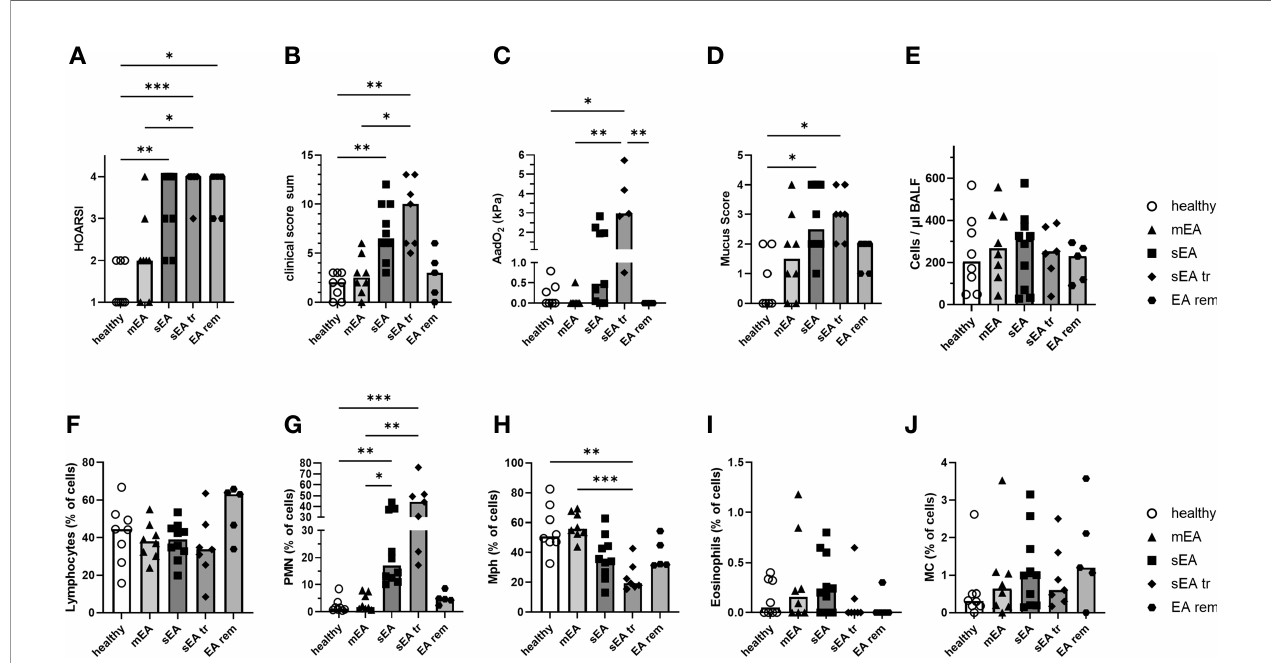
FIGURE 1 | Clinical presentation and BAL cytology con fi rm group classi fi cations of the horses. Horses were classi fi ed as respiratory healthy (n=8) or asthmatic [mild – moderate (mEA, n=8), severe (sEA, n=10), severe and pre-treated (sEA tr, n=7), EA in remission of symptoms (EA rem, n=5)]. The results per group are presented in scatter plots with bars indicating group medians of: (A) the history of symptoms (HOARSI), (B) clinical presentations (score sum), (C) alveolar to arterial oxygen pressure difference (AadO 2 , increased in sEA tr); (D) mucus score (increased in sEA and sEA tr) and (E) cell counts per µl in BALF. Results from microscopic assessment of nucleated BAL cells (cytospins) are likewise presented for: (F) lymphocytes, (G) polymorphonuclear cells (PMN), (H) macrophages (Mph), (I) eosinophils, and (J) mast cells (MC). Frequencies of (G) PMN were increased in severely asthmatic horses (sEA and sEA tr) and (H) frequencies of Mph were reduced in the sEA tr group compared to healthy horses. Asterisks represent differences between groups with p<0.05 in Kruskal-Wallis